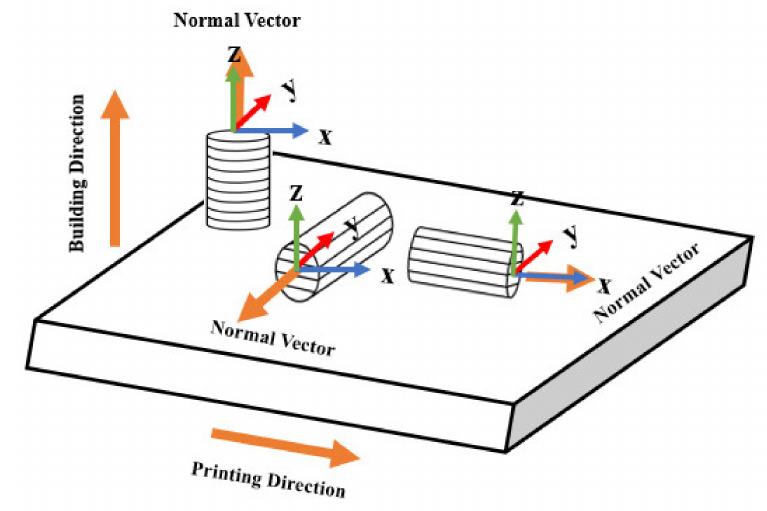
Figure 4. Standard samples drawn in x -, y -, and z -directions and printed in the x -direction, while lines on the sample shows the build